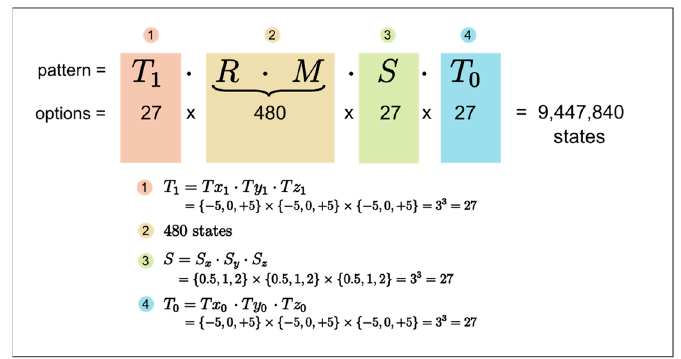
Figure 10. Total number of possible exercises.